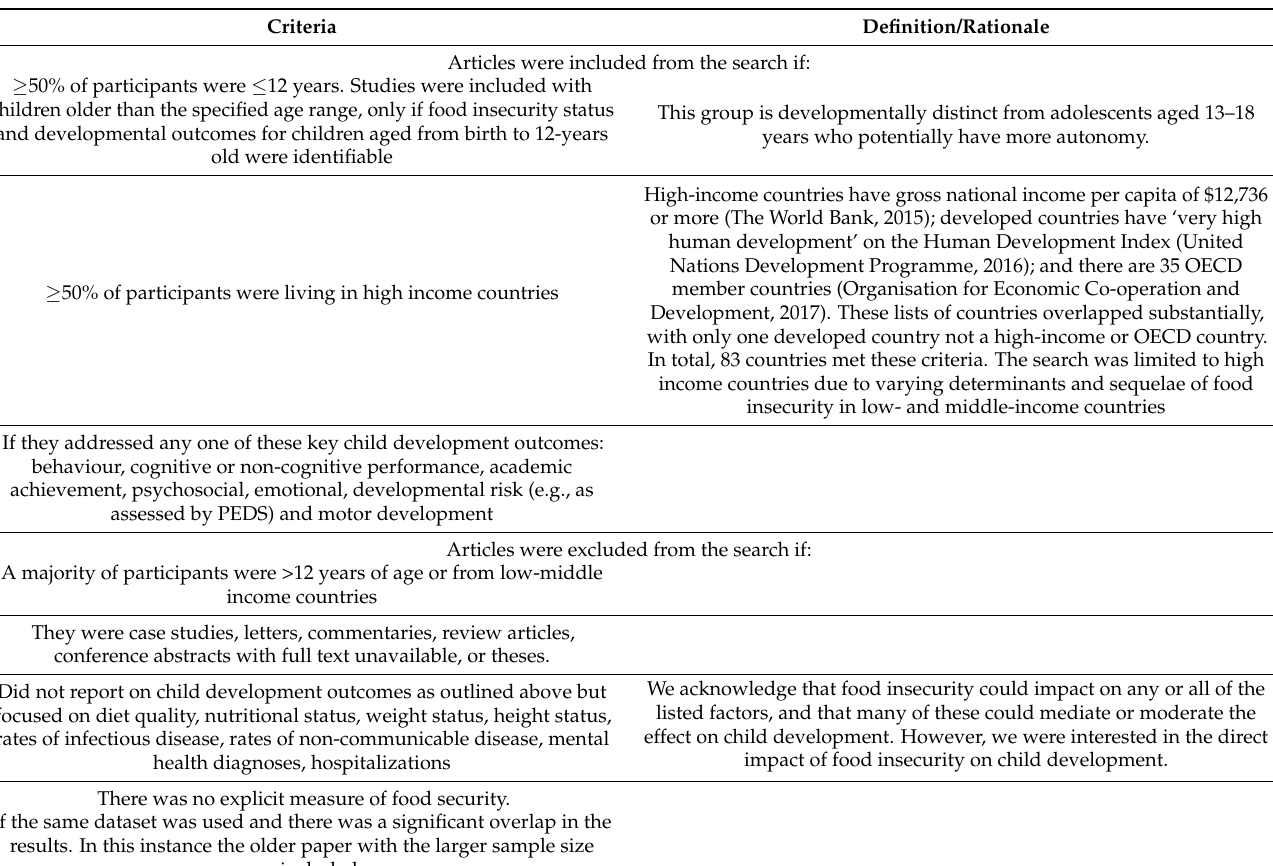
Table 1. Inclusion and exclusion